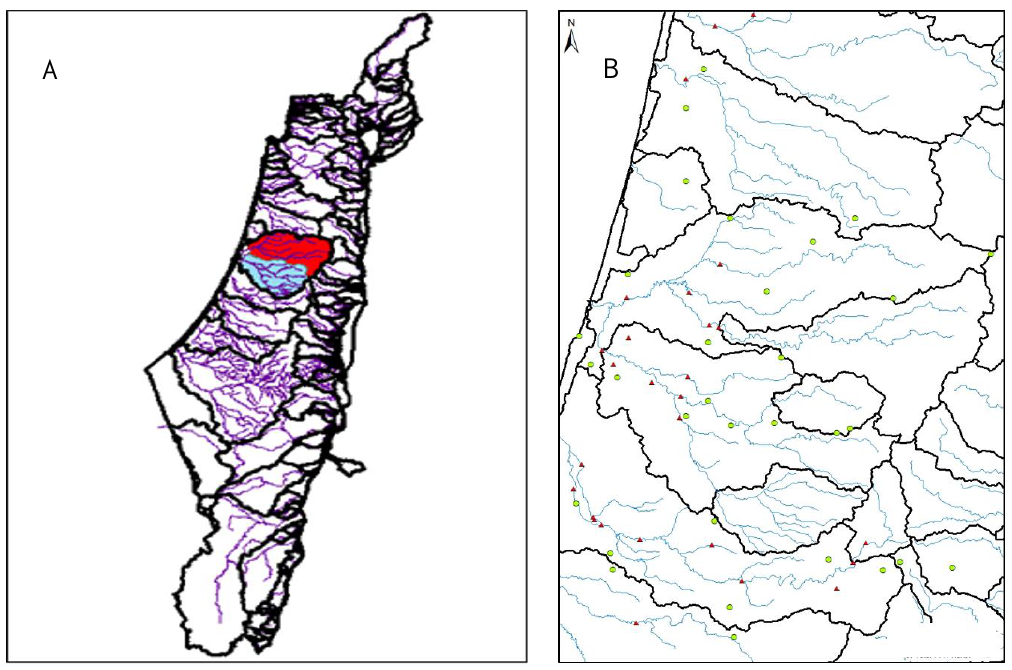
Figure 3. The location of the Yarqon-Ayalon basin in central Israel ( A ) and the rain gauges (im green circles) and hydrometric stations in (red triangle) the basin ( B ).